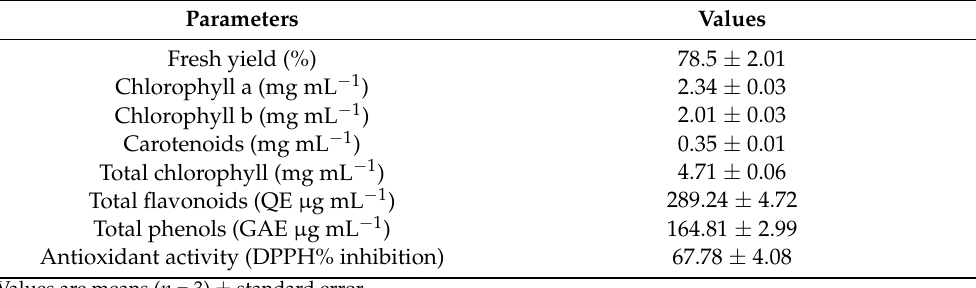
Table 3. Biochemical composition of wheat grass juice.